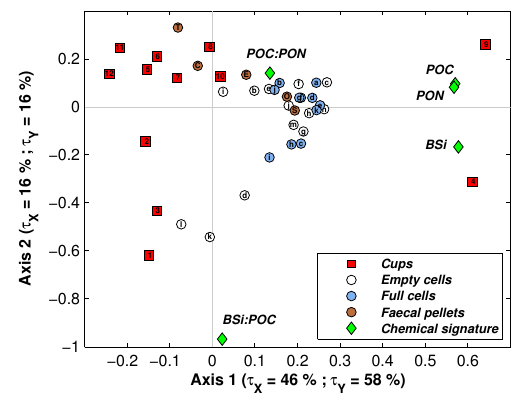
Figure 7. Projection of the cups (red squares), the biological factors (circles) and the chemical factors (green diamonds) in the first two latent vectors of the partial least-squares regression. Circled labels refer to the full and empty species listed in Fig.